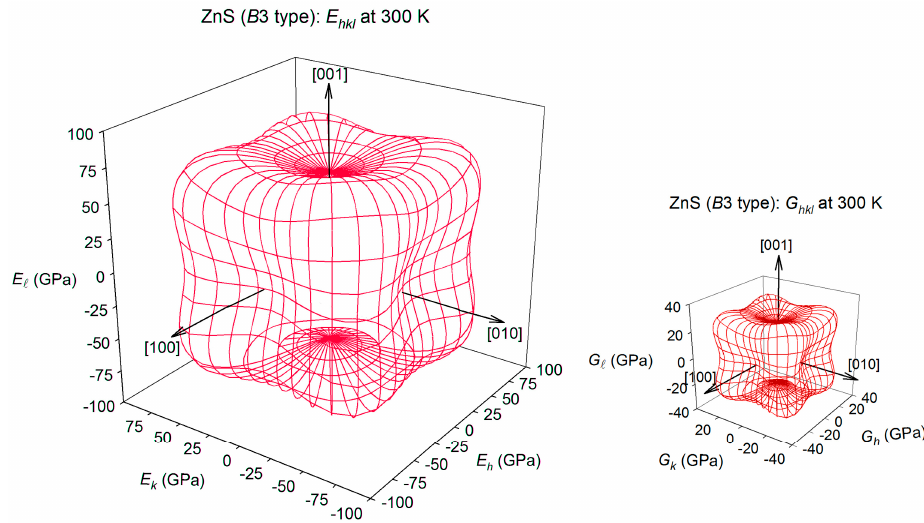
Figure 21. The spatial distributions of the Young’s modulus E hkl and shear modulus G hkl for cubic zinc sulfide (ZnS sphalerite) at 300 K.